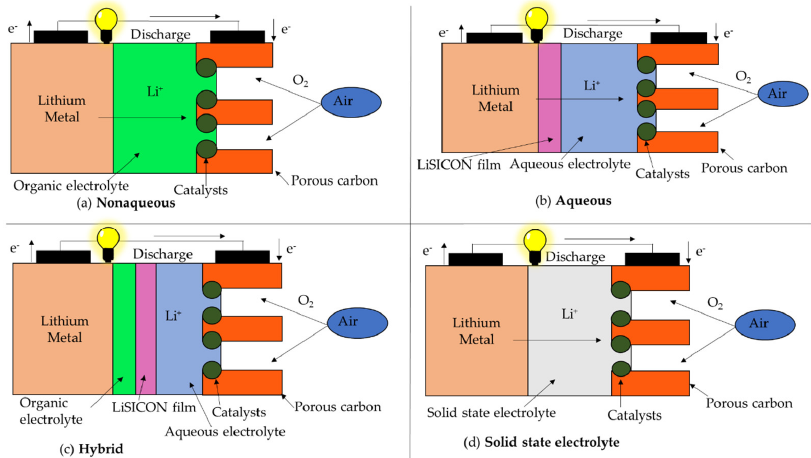
Figure 9. Metal–Air batteries cell configuration. Table 9. Metal–Air Batteries. Characteristics and manufacturers.